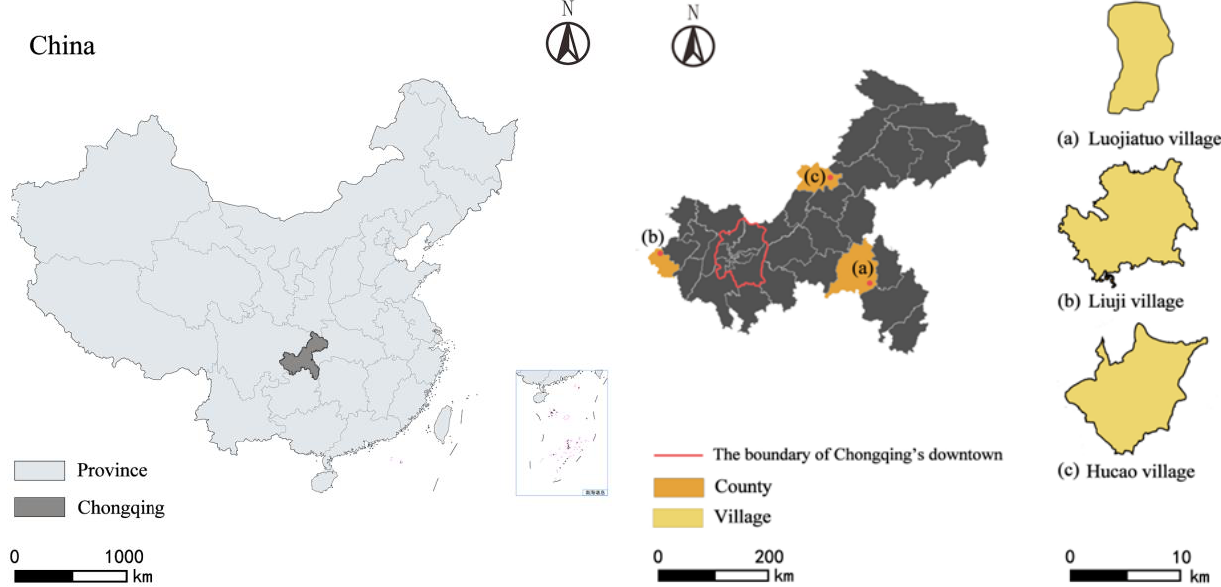
Figure 1. The map of the study area. ( a ) Luojiatuo village ( b ) Liuji village ( c ) Hucao